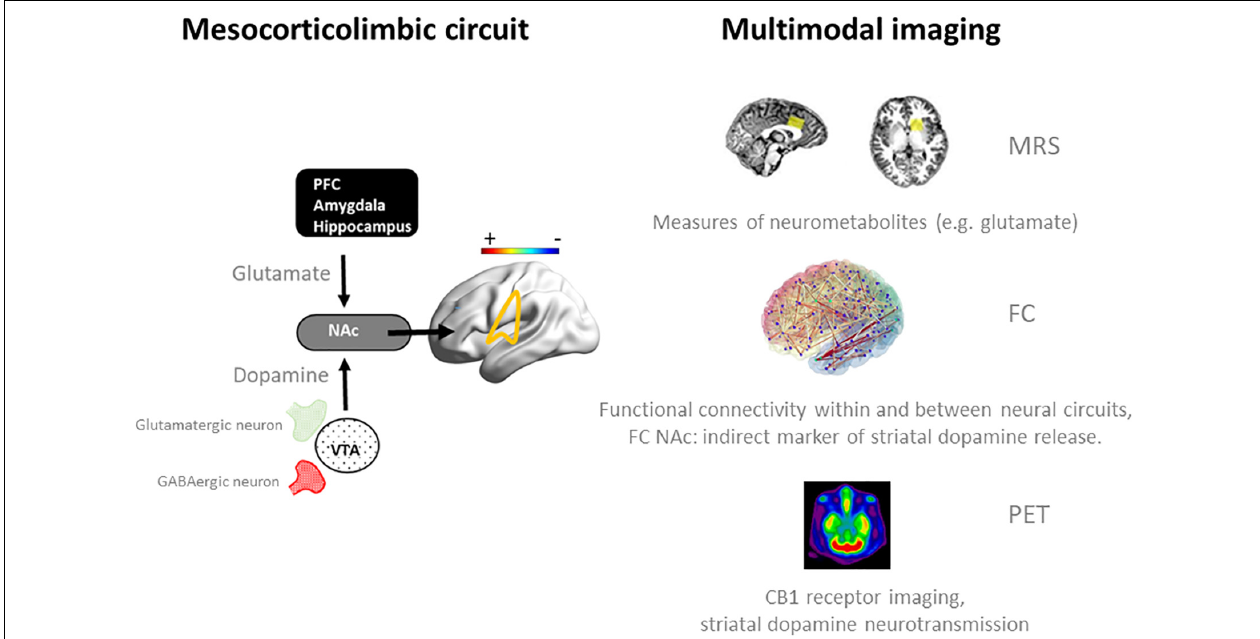
FIGURE 1 | Schematic representation of neurotransmission and functional connectivity in the mesocorticolimbic circuit in the normal brain (32) (left panel) and multimodal imaging measures (right panel) that can be employed to assess dynamics within this circuit during an acute challenge with THC and when sober. Magnetic Resonance Spectroscopy (MRS) has been successfully used to quantify frontal and striatal glutamate concentrations in cannabis users during intoxication and when sober (33, 34). fMRI measures of functional connectivity (FC) have provided functional associations within and between neural networks in cannabis users during intoxication (33, 35, 42) and when sober (15–17, 42), and can be used as an indirect marker of striatal dopamine release during cannabis intoxication (33, 81). Positron emission tomography (PET) can be used to determine CB1 receptor density at glutamatergic and GABAergic neurons in the striatum of cannabis users (60, 62) and to determine dopamine displacement at D2/D3 receptors as a measure of dopamine transmission during cannabis intoxication (36). NAc, nucleus accumbens; PFC, prefrontal